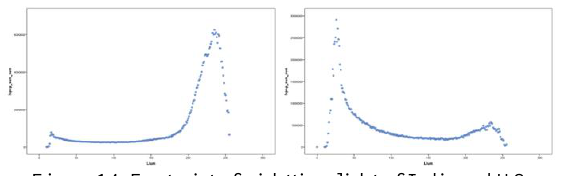
Figure 14. Footprint of nighttime light of India and US In the X-axis night light intensity from zero to 255 and in the Y-axis the population. As can be seen, while in US (left